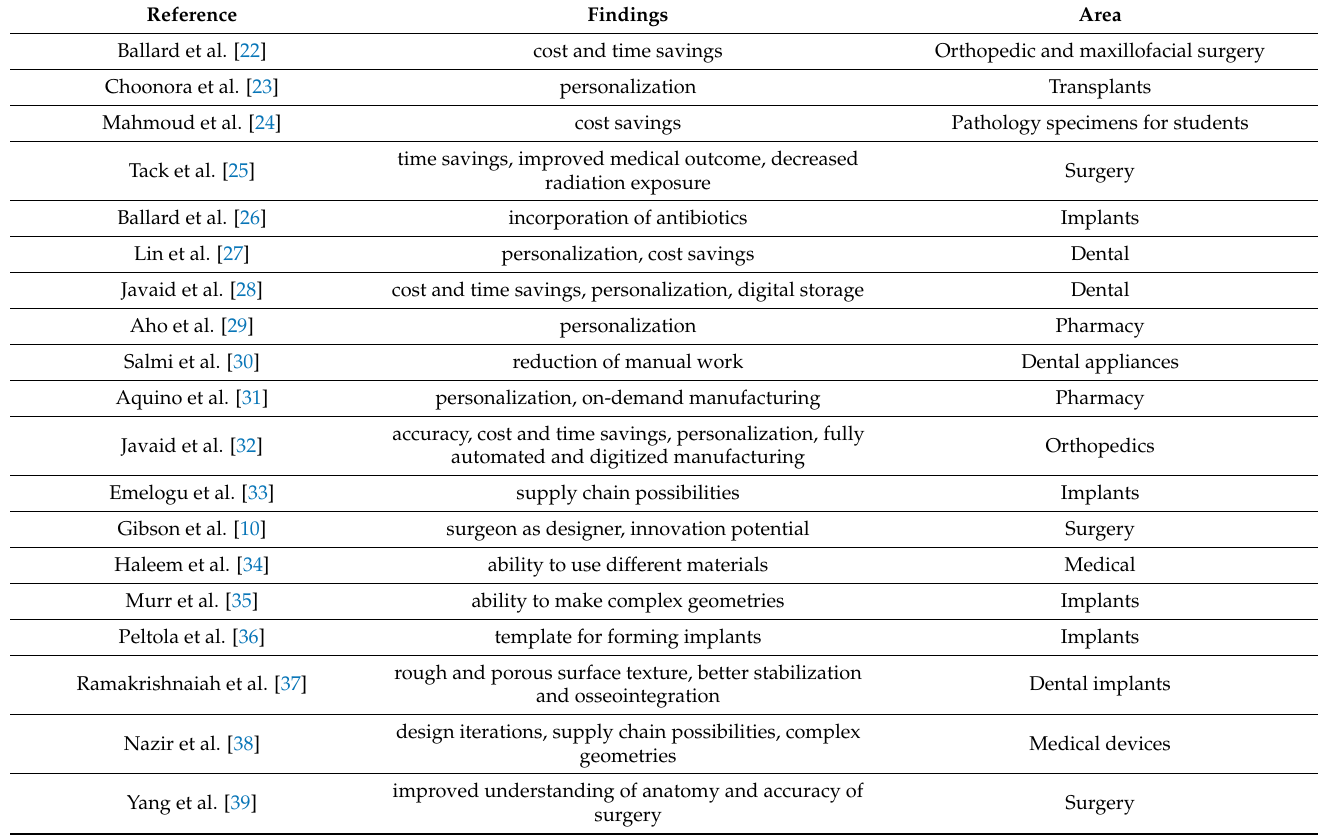
Table 1. Some of the benefits of additive manufacturing (AM) in medical and dental